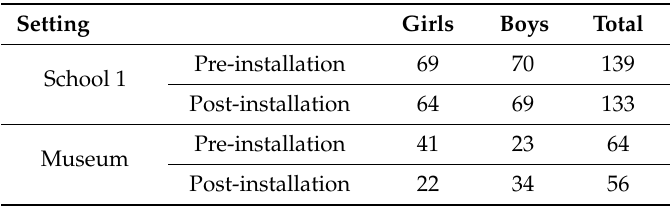
Table 5. Participant recruitment handwashing